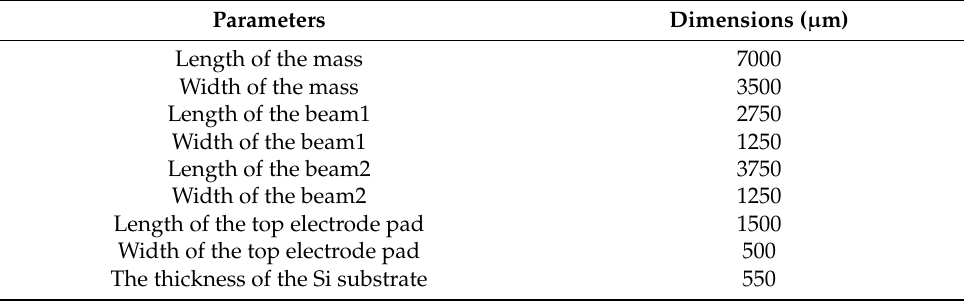
Figure 1. ( a ) Schematic view of the tri-axial piezoelectric accelerometer with folded beams; ( b ) Geometric parameter of the sensor and electrical connections of the electrode pads. Table 1. The structure parameters of the tri-axial MEMS accelerometer.